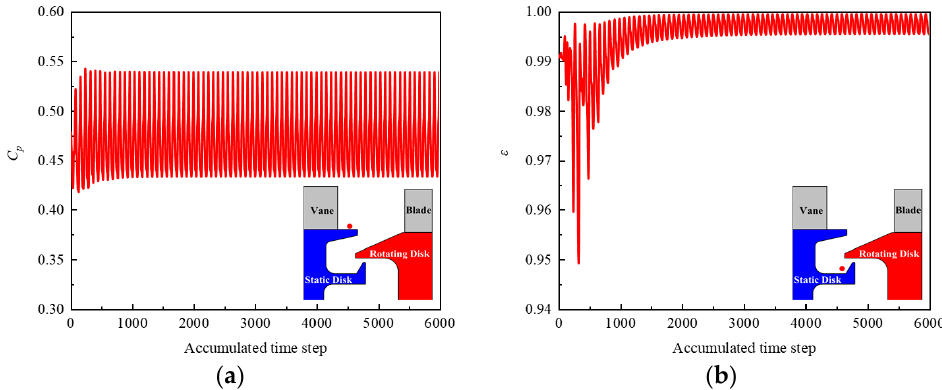
Figure 3. Unsteady pressure and sealing effectiveness convergence history curves. ( a ) downstream of the vane trailing edge; and ( b ) sealing